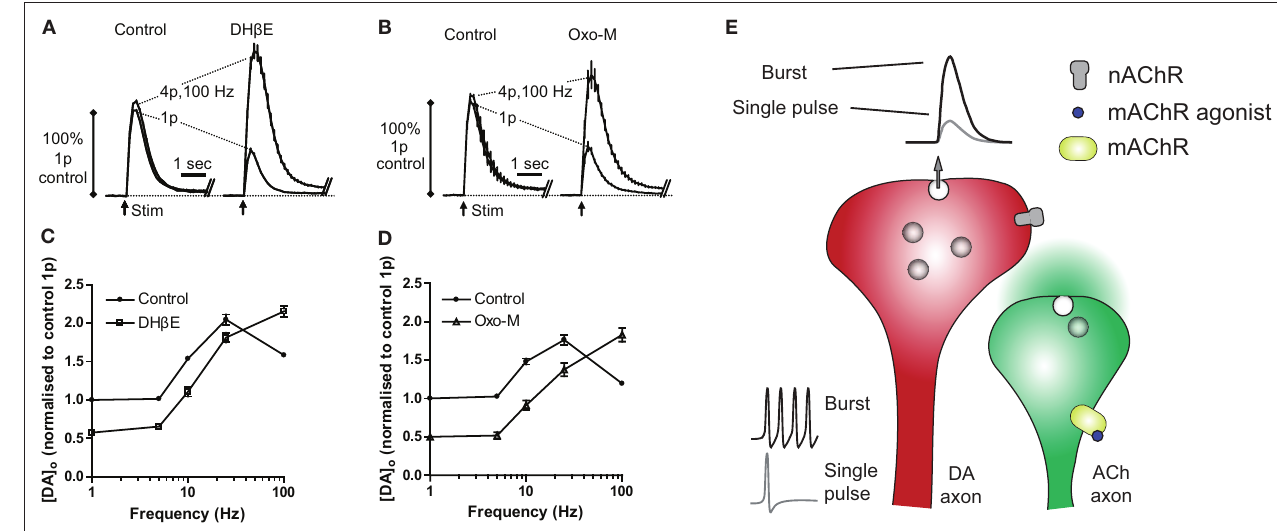
Figure 1 | Nicotinic (nAChrs) and muscarinic (mAChrs) receptors modify four pulse trains (1–100 Hz) in control (filled circles) or DH β E (squares) or Oxo-M frequency-dependence of dopamine release. (A,B) Profiles of mean (triangles) normalized to [DA] released by a single pulse in control conditions. o extracellular concentration of dopamine [DA] ± SEM versus time in NAc after Either blockade of nAChRs with DH β E, or activation of mAChRs with Oxo-M o stimuli (arrows) of either a single pulse (1p) or a high frequency burst (4p/100 Hz) results in increased frequency-dependence of dopamine release as described in control or drug conditions (DH β E, 1 μM; Oxo-M, 10 μM). Data are normalized previously (see Rice and Cragg, 2004; Exley et al., 2008; Threlfell et al., 2010). (e) to peak [DA] released by 1p in controls. Either β 2*-nAChR antagonist (DH β E) or Schematic illustrating the frequency-dependence of dopamine release during o mAChR agonist (Oxo-M) reduce release by a single pulse and enhance release deactivation of nAChRs as a result of either blockade/desensitization by a burst thereby increasing the contrast between dopamine released by burst and non-burst activity. (C,D) Mean peak [DA] ± SEM versus frequency during o